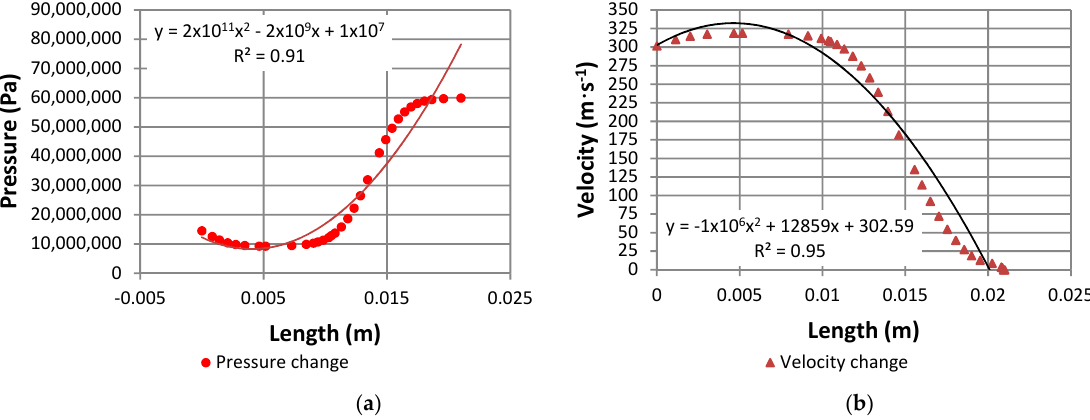
Figure 14. The variation curves of pressure ( p ) ( a ) and velocity ( υ ) ( b ) for volume flow rate 0.01335m 3 · s − 1 (800 L · min − 1 ).